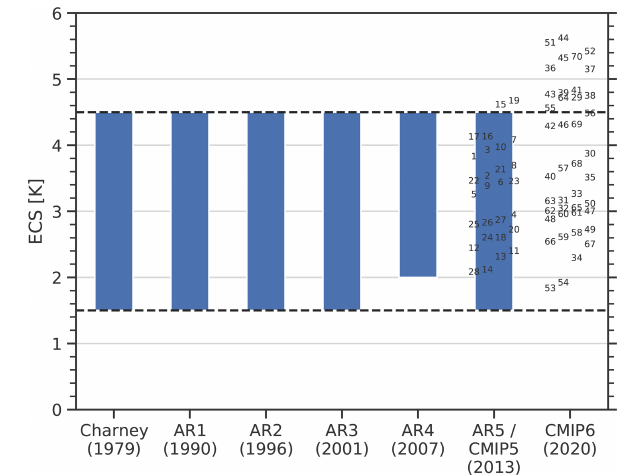
Figure 1. Assessed ECS ranges (blue bars) from the Charney report (Charney et al., 1979) and the different Assessment Reports (ARs) of the Intergovernmental Panel on Climate Change (IPCC). The numbers correspond to individual CMIP5 and CMIP6 models; see Tables A1 and A2 for details. Adapted and updated from Meehl et al.